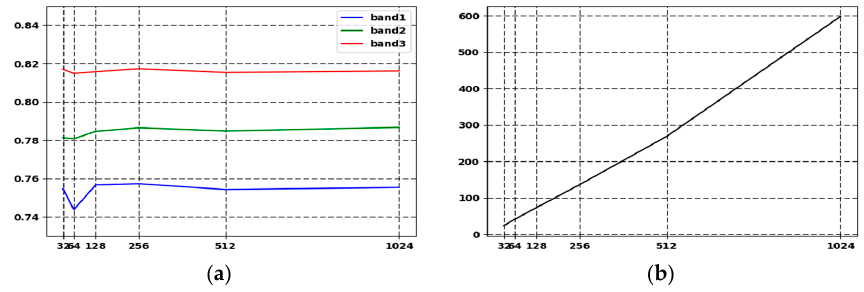
Figure 5. RF regression implementation graph: ( a ) OOB-R 2 ; and ( b ) training time.